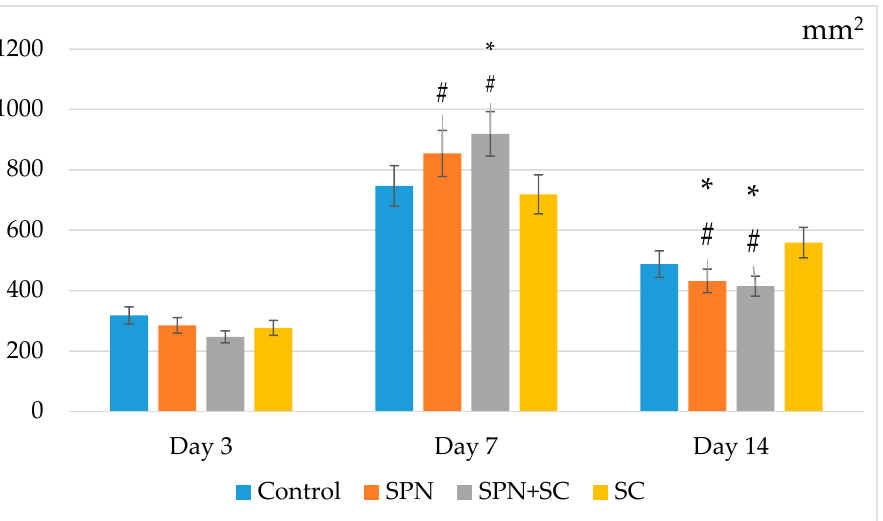
Figure 12. The number of resident and non-resident cells (total amount on average for wounds of different groups). Note: *—Difference from the control group at p < 0.05; # —Difference from the SC group at p < 0.05 (Mann–Whitney U test). Mean and standard deviation are presented.